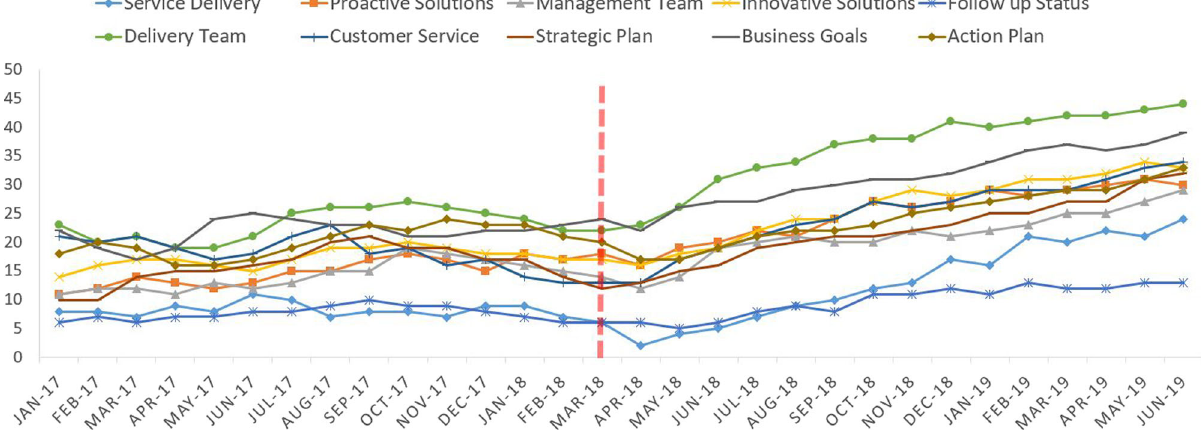
Fig. 7 The top 10 positive topics across all reviews before and after the implementation of the model. In March 2018, a live modeling process was initiated for topics. Using the model, it shows the number of positive topics and their trends in each category prior to and following the application of the